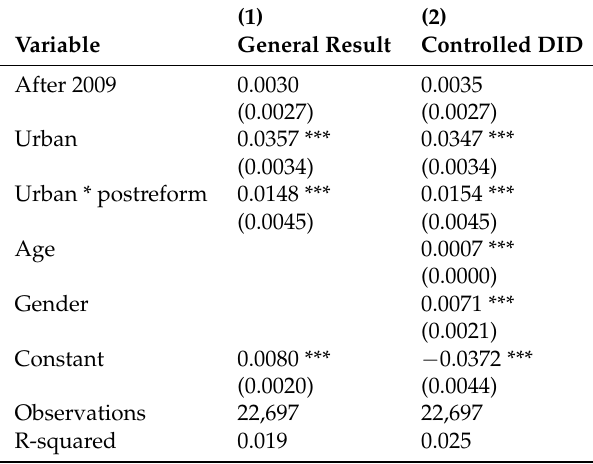
Table 7. Robustness check: treatment effect of health care reform on health care utilisation.